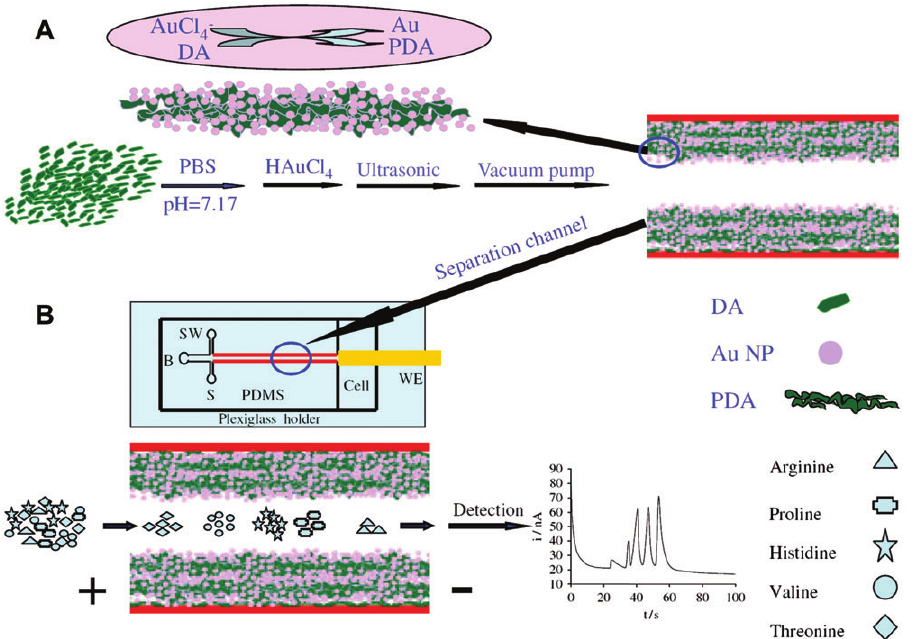
Figure 6 (A) Construction of PDA/AuNP-modified PDMS microfluidic devices. (B) Separation mechanism of the electrophoretic microchip system for analysis of five amino acids integrated with end-channel electrochemical detection (Liang et al. 2011